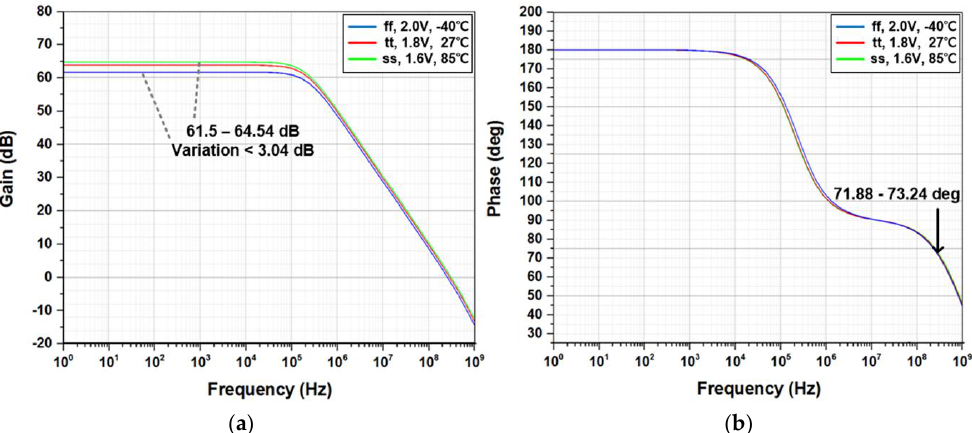
Figure 10. Fully-differential amplifier characteristic over process-voltage-temperature (PVT) variations (simulated): ( a ) gain ( b ) phase margin.